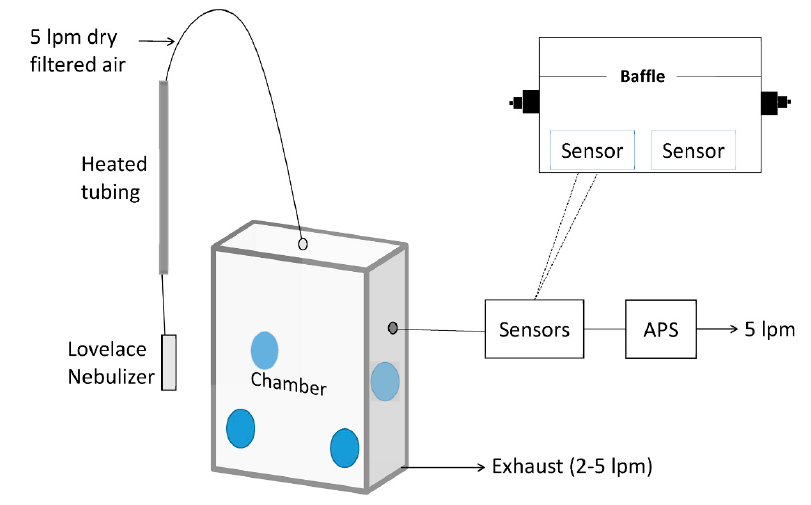
Figure 8. Schematic of the experimental set-up realized by Austin’s group. The blue circles indicate the location of the mixing fans inside the chamber (2015) (image reprinted under the terms of the Creative Commons Attribution License which permits unrestricted use; PLoS ONE 10(9), e0137789, doi:10.1371 /